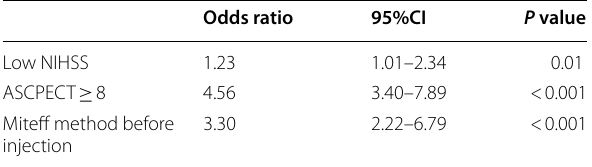
Table 4 Predictors of good functional outcome in acute ischemic